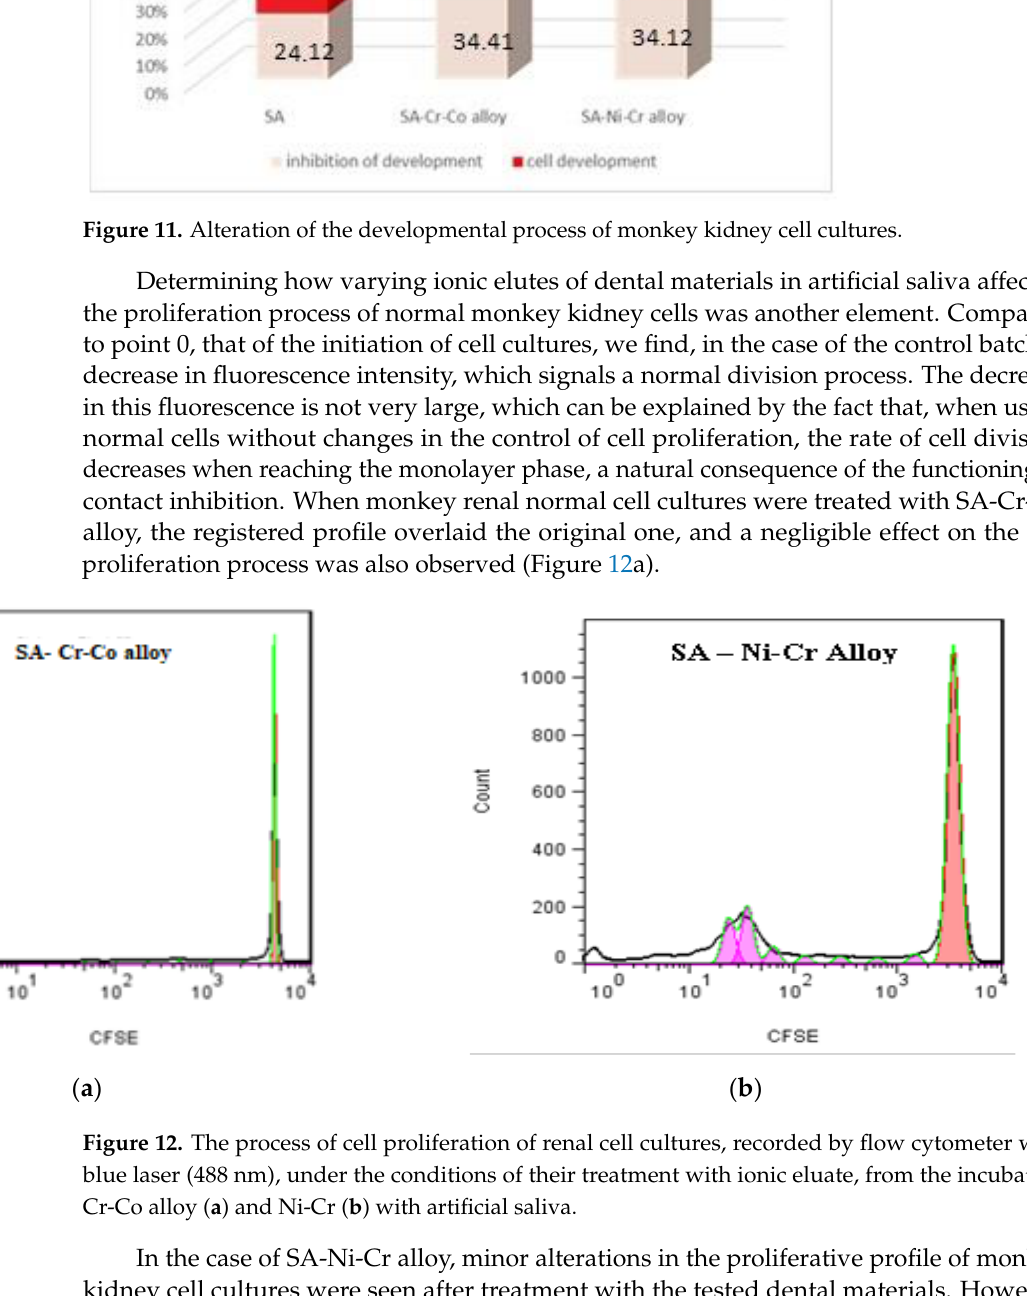
( b ) Figure 13. The process of apoptosis and cell viability in monkey renal cell cultures, recorded in con- tinuous flow of cells at the flow cytometer, under the conditions of their treatment with artificial saliva and ionic elutes, from incubation of Cr-Co ( a ) and Ni-Cr ( b ) with artificial saliva.